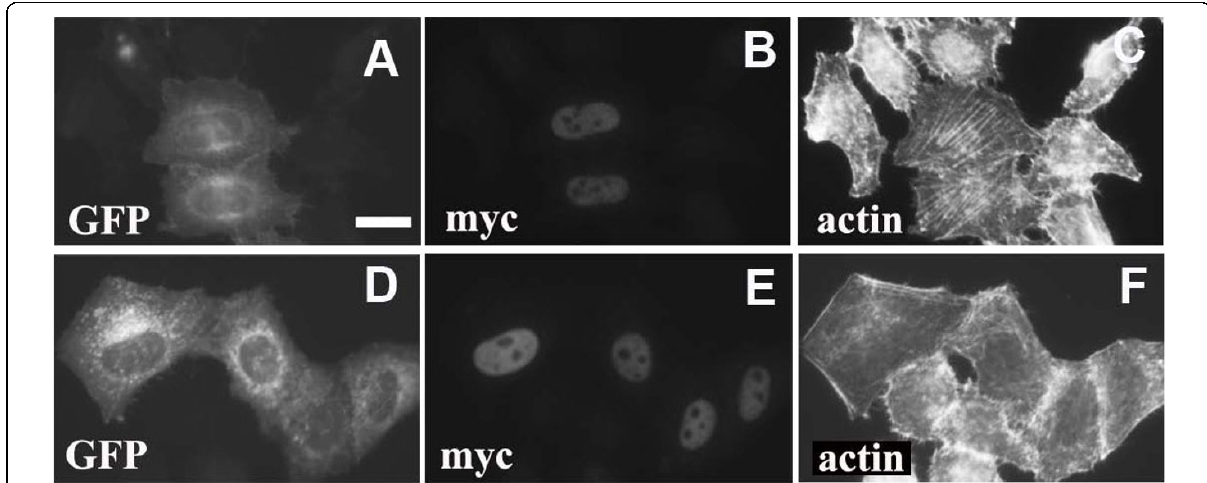
Figure 4 Dominant negative RhoA inhibits stress fiber formation . A-C . Cells were co-transfected with GFP-DN-Cdc42 (N17Cdc42) and pRK5- myc-LKB1 constructs. D-F . Cells were co-transfected with GFP-DN-RhoA (N19RhoA) and pRK5-myc-LKB1. Cells expressing both GFP and myc were counted and scored for stress fiber formation. Scale bar = 20 μ m.